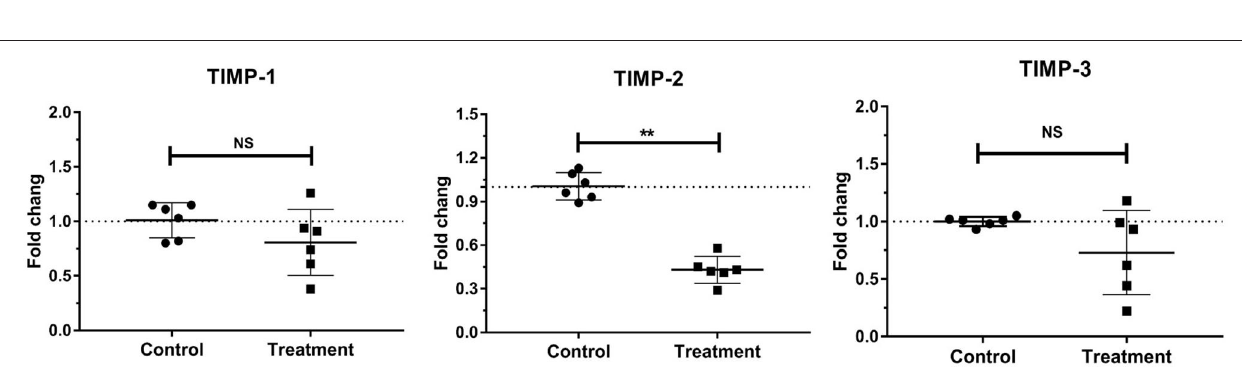
including collagen, laminin, MPs, versican, aggrecan, and keratin (37). MPs are the primary proteases involved in ECM remodeling under physiological and pathological conditions (38, 39). Thus,